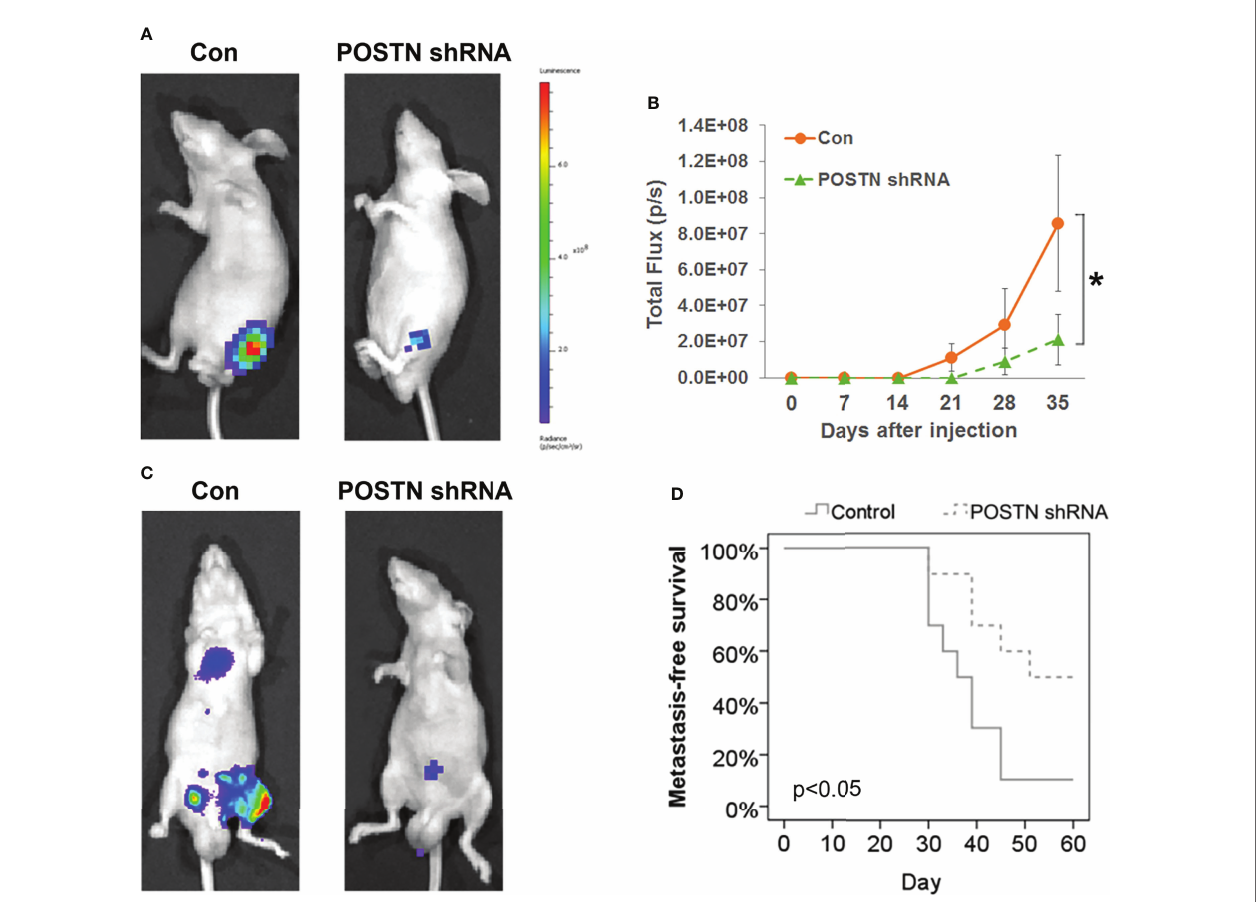
FIGURE 2 | POSTN knockdown suppresses the bone metastasis capability of PCa cells. (A) MDA PCa 2b cells or POSTN-knockdown MDA PCa 2b cells were injected in the intramedullary cavity of the tibia. Shown are representative whole-animal luciferase imaging of mice 5 weeks postsurgery ( n = 8/group). (B) Bioluminescent curve of tumor development [related to (A) ]. (C) MDA PCa 2b cells or POSTN-knockdown MDA PCa 2b cells were injected into the left ventricle in nude mice. Representative whole-animal luciferase imaging of mice 60 days postsurgery ( n = 8/group). (D) Metastasis-free survival [related to (C) ]. * p <